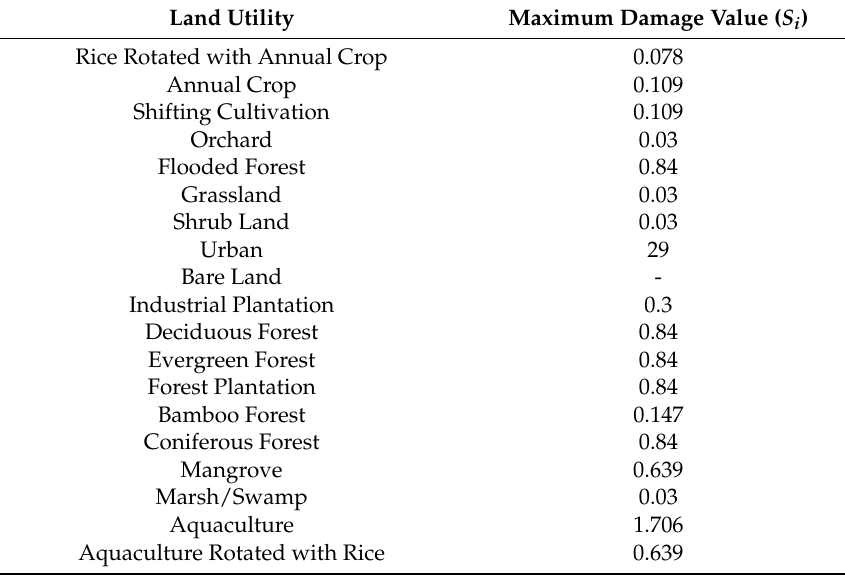
Table A1. Land utilities with corresponding maximum damage values used in this